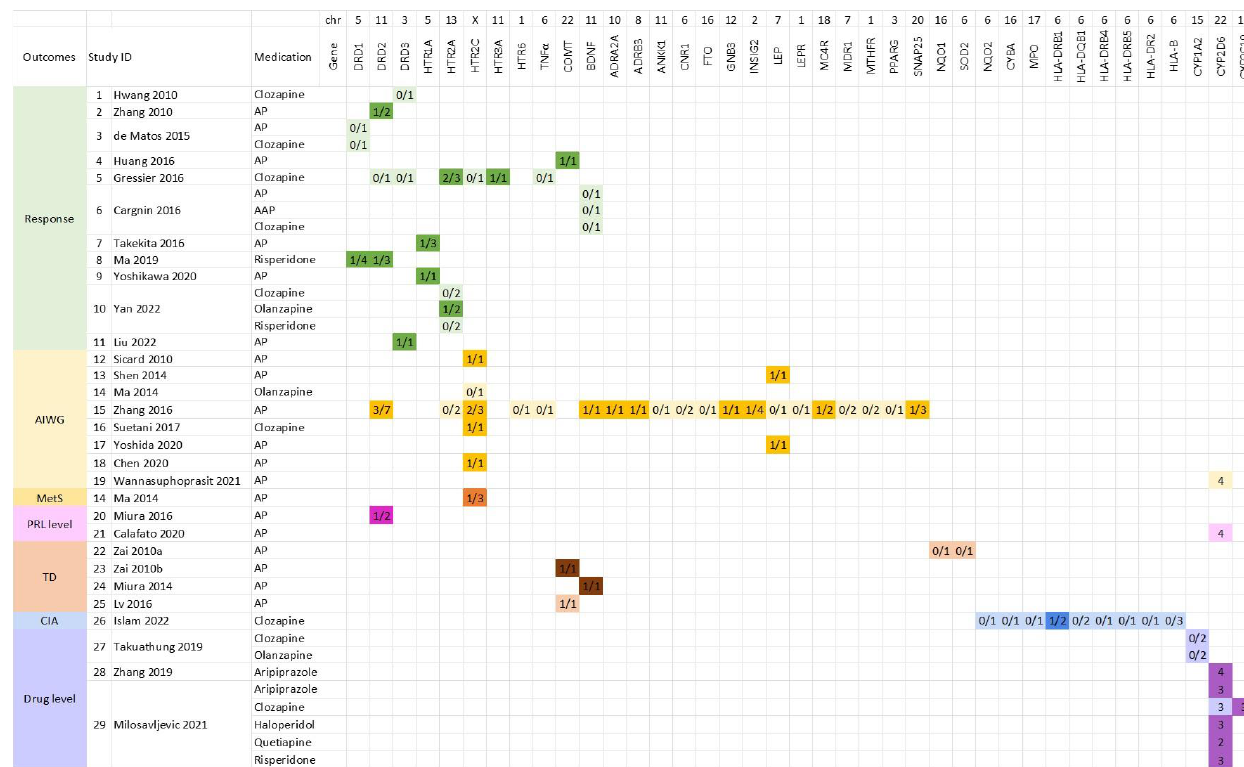
Figure 3. Heatmap of genes studied in each included meta-analysis. Footnote: Assorted colors indicate different outcomes. Lighter colors indicate that no SNP belonging to the gene was found to be significant for the corresponding outcomes/study. Darker colors indicate at least one SNP belonging to the gene exhibited a significant association with the corresponding outcome/Study. The numbers inside the boxes “a/b”: A presents the number of SNPs with significant associations; b presents the number of SNPs investigated in the specified study. For CYP2D6 and CYP2C19 , the number inside represents the number of phenotypes of this enzyme analyzed. References: Study 1, Hwang, 2010 [34]; 2, Zhang, 2010 [46]; 3 de Matos, 2015 [47]; 4, Huang, 2016 [43]; 5, Gressier, 2016 [31]; 6, Cargnin, 2016 [40]; 7, Takekita, 2016 [44]; 8, Ma, 2019 [48]; 9, Yoshikawa, 2020 [45]; 10, Yan, 2022 [41]; 11, Liu, 2022 [42]; 12, Sicard, 2010 [35]; 13, Shen, 2014 [51]; 14, Ma, 2014 [49]; 15, Zhang, 2016 [32]; 16, Suetani, 2017 [53]; 17, Yoshida, 2020 [52]; 18, Chen, 2020 [50]; 19, Wannasuphoprasit, 2021 [54]; 20, Miura, 2016 [55]; 21, Calafato, 2020 [56]; 22, Zai, 2010a [59]; 23, Zai, 2010b [60]; 24, Miura, 29, Milosavljevic, 2021 [62]. Abbreviation: Chr, chromosome; AP, antipsychotics; AIWG, antipsychotic- induced weight gain; MetS, metabolic syndrome; PRL, prolactin; TD, tardive dyskinesia; CIA, clozapine-induced